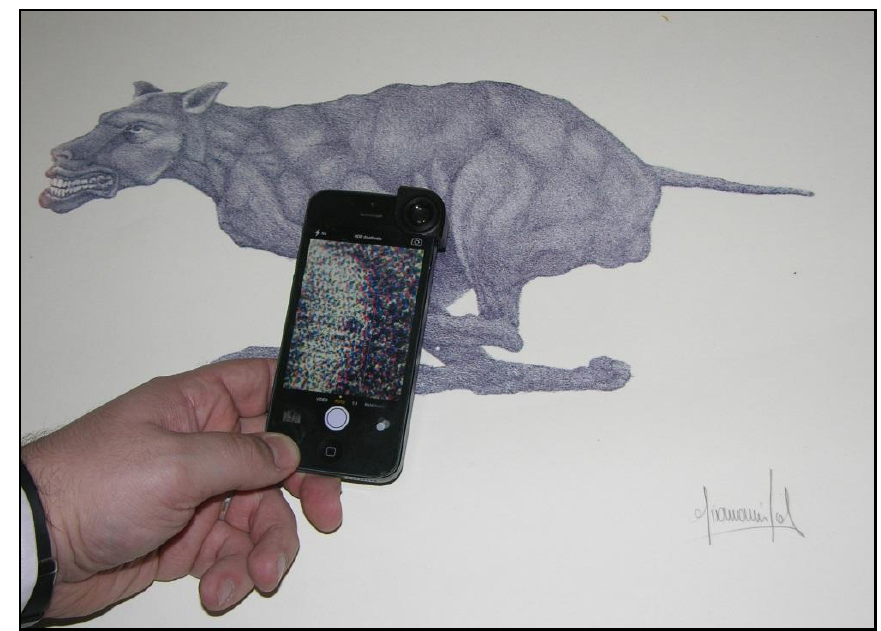
Figure 4. Example of smartphone used during